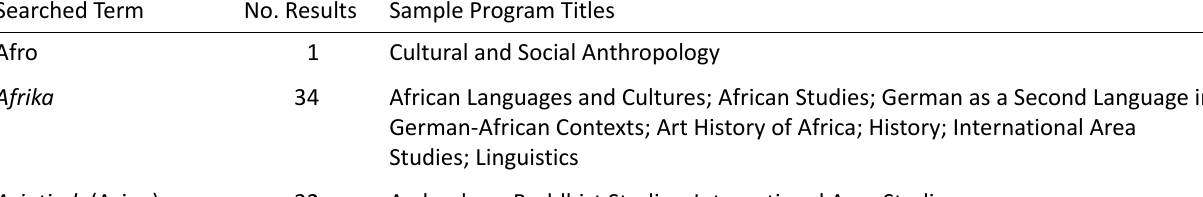
Table 1. Existing degree courses related to identity studies at public universities in Germany. Searched